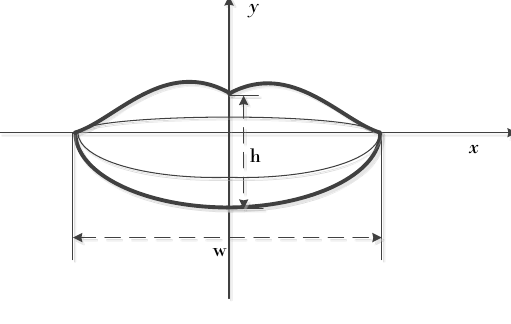
Figure 3. Lip model